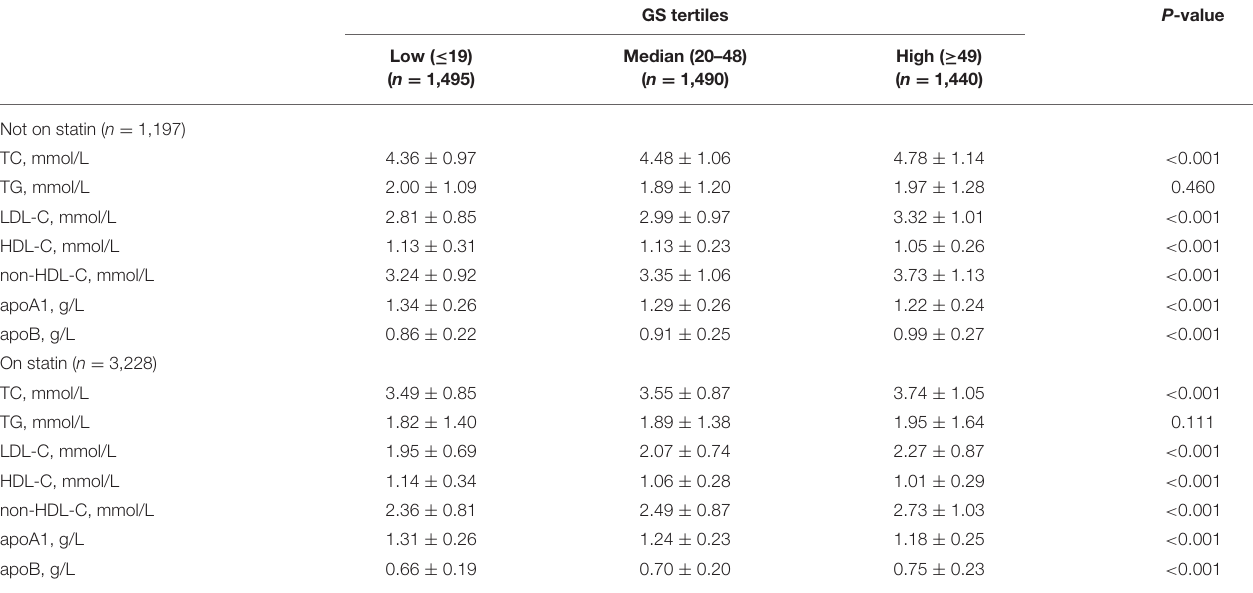
TABLE 2 | Statin-stratified lipid levels by GS with adjustment for age and gender.